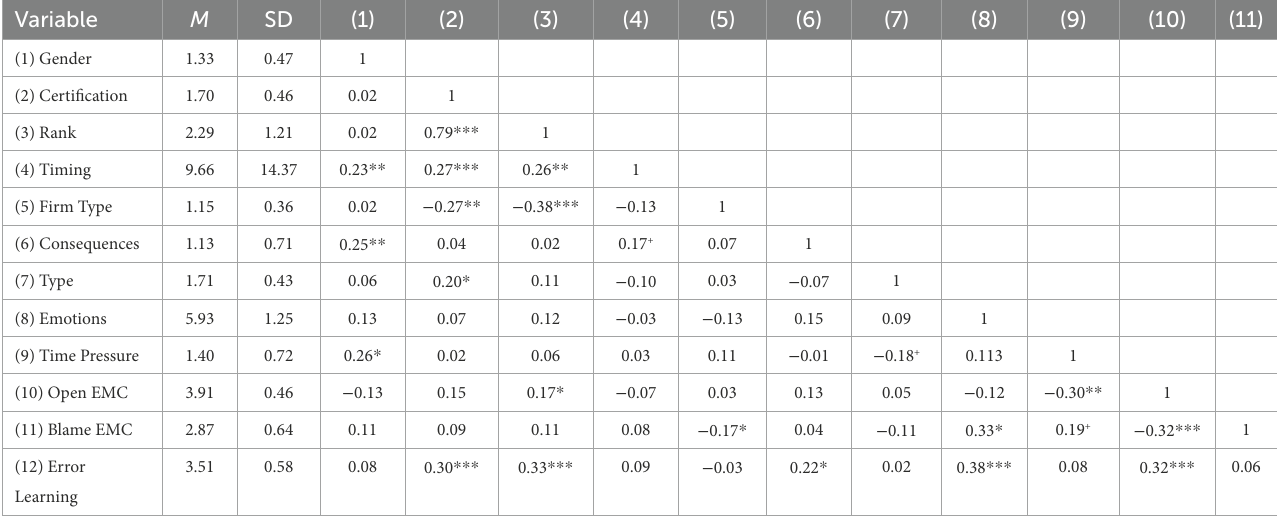
TABLE 1 Means, standard deviations, and correlations among variables.